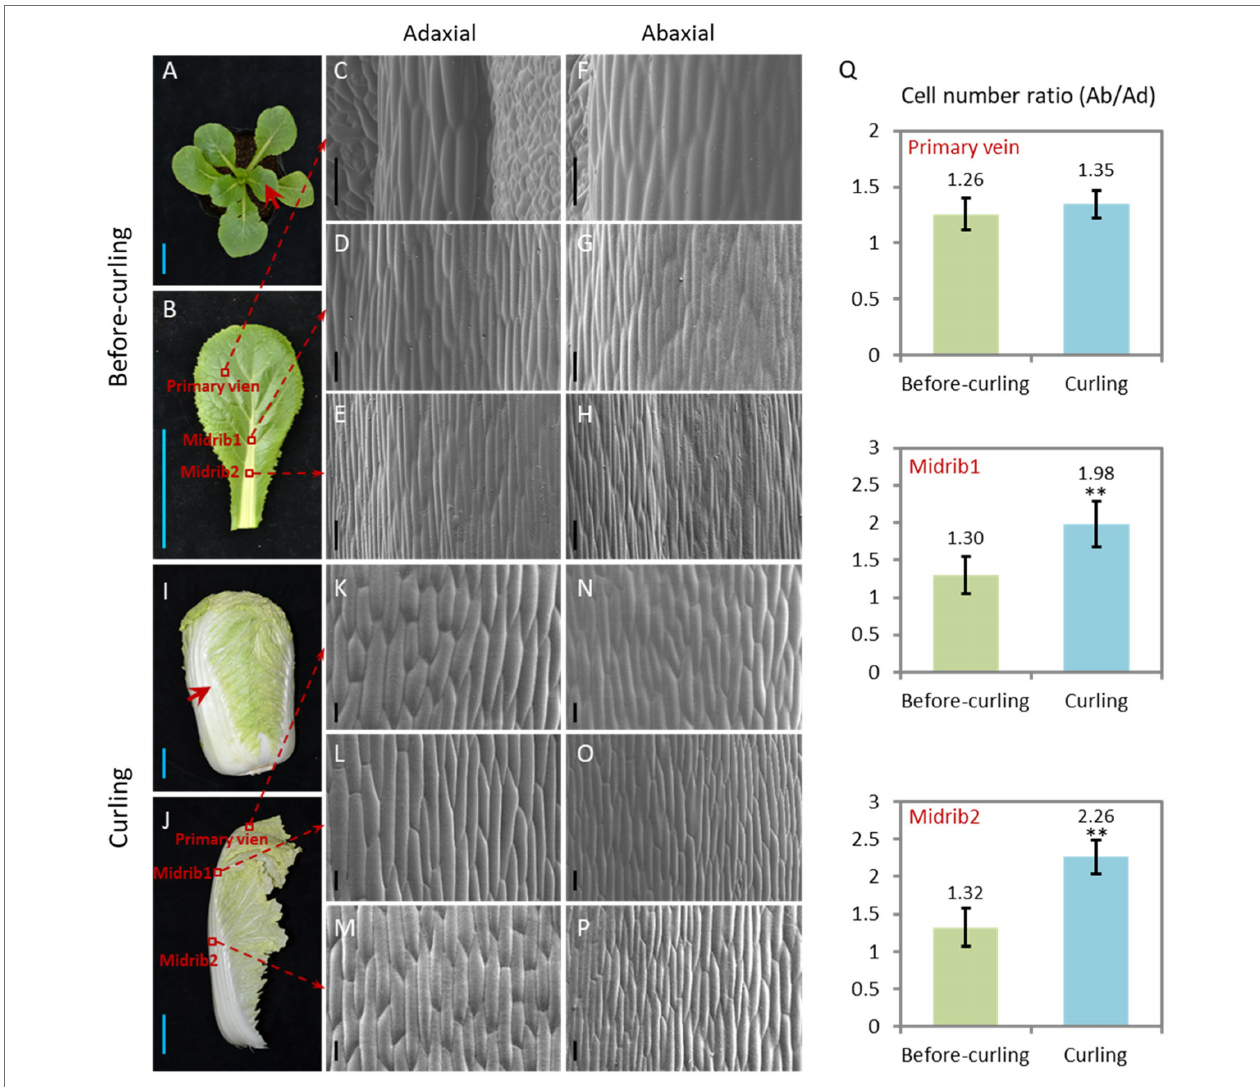
FIGURE 2 | Epidermal cells of the curling veins show an asymmetrical growth pattern. Morphological observation of the adaxial/abaxial (abbreviated to Ad/Ab) epidermal cells of the leaf veins in before-curling (A–H) and curling (I–P) plants. (C/F,D/G,E/H) Scanning electron micrographs of the Ad/Ab cells of the primary vein, higher midrib part (midrib 1), and lower midrib part (midrib 2), respectively, in before-curling plants. (K/N,L/O,M/P) Scanning electron micrographs of the Ad/ Ab cells of the above corresponding vein parts in curling plants. (Q) The cell number ratios (Ab/Ad) of leaf vein epidermis. Red circles and arrows indicate the leaf vein areas used for photographing and cell number calculation; Ad/Ab, adaxial/abaxial; Values are means ± SD ( n = 6–23). Asterisks indicate significant differences using Student’s t -test ** p < 0.01. Scale bars: 5 cm (A , B , I , J) , 100 μ m (C – H , K – P)